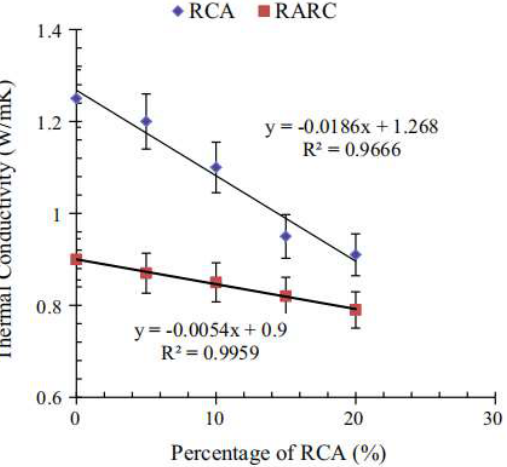
Figure 26. Relationship between the thermal conductivity of concrete mixture made with recycled aggregate and rubber aggregate and the replacement rate of recycled aggregate [20].